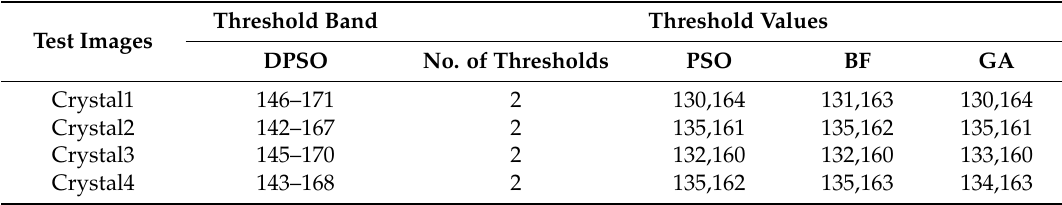
Table 6. Comparative analysis of threshold values obtained by the Otsu-based DPSO method with other bio-inspired multilevel thresholding methods.